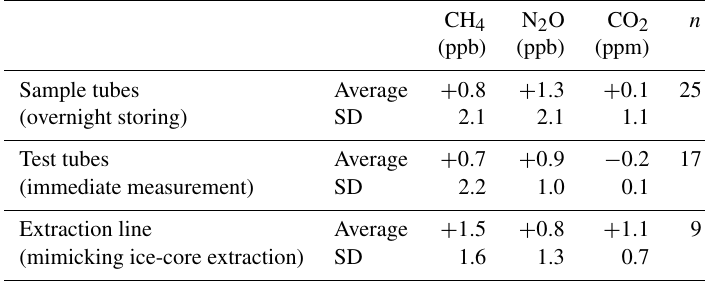
Table 4. Test results using a standard gas (STD-A) for greenhouse